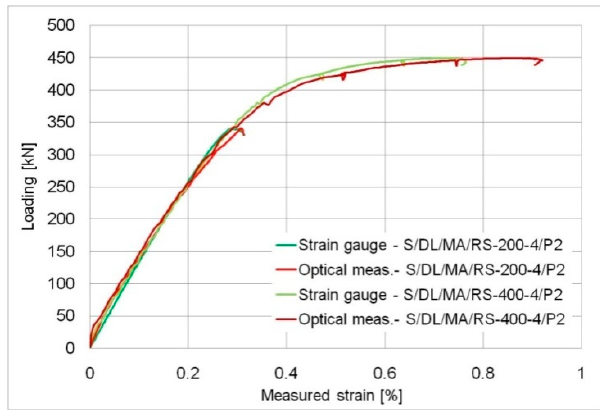
Figure 12. Comparison between the values measured using strain gauges and optical method.